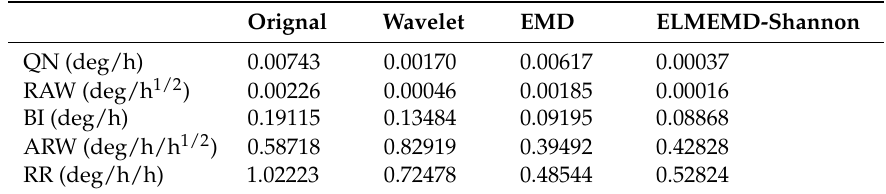
Table 3. Errors of the z -axis gyro signal.